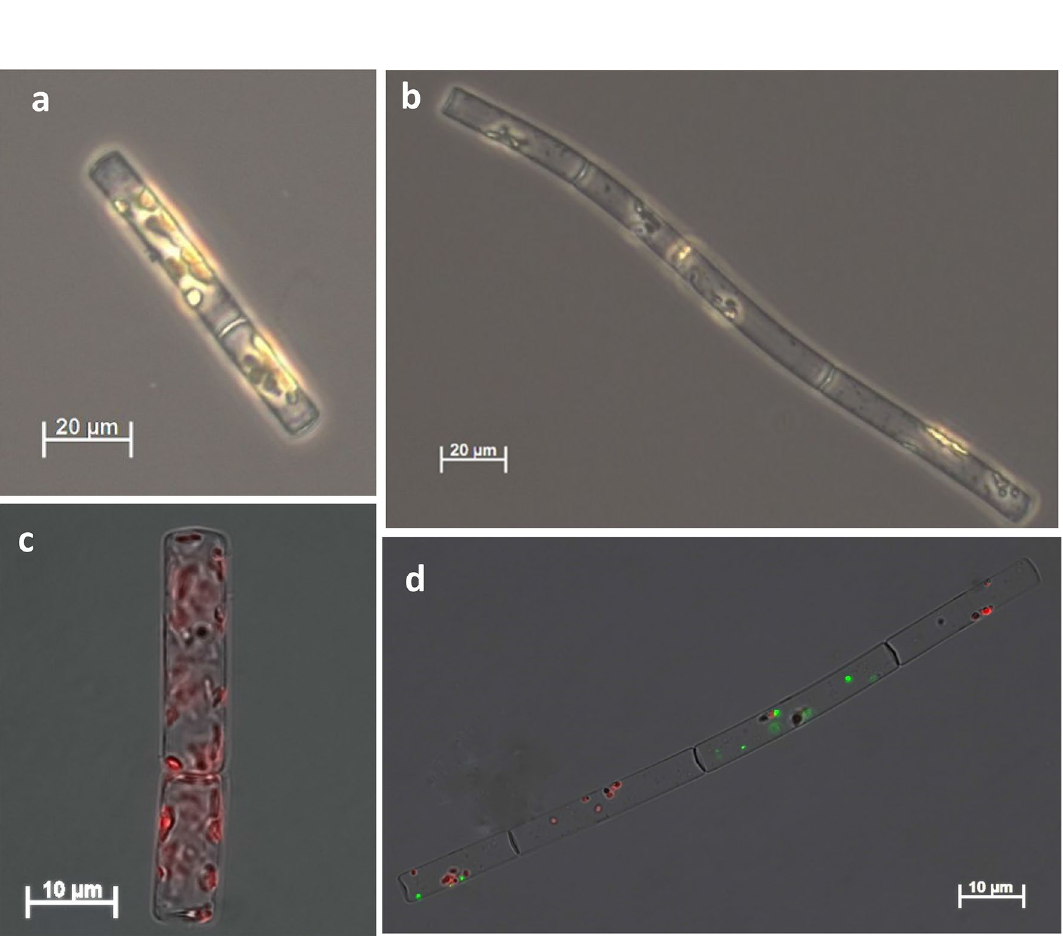
Figure 8. Light micrograpy of L. aporus ( a – d ). Cells of L. aporus grown in F/2 ( a , c ) and P-limit ( b , d ) medium. L. aporus cell from a culture in P-limit medium after incubation with alkaline phosphatase substrate from the ELF 97 Phosphatase Detection Kit. Chloroplast autofluorescence is shown in red. The fluorescent signal from dephosphorylated alkaline phosphatase substrate is shown in green. It accumulates at the location of alkaline phosphatase activity, along the